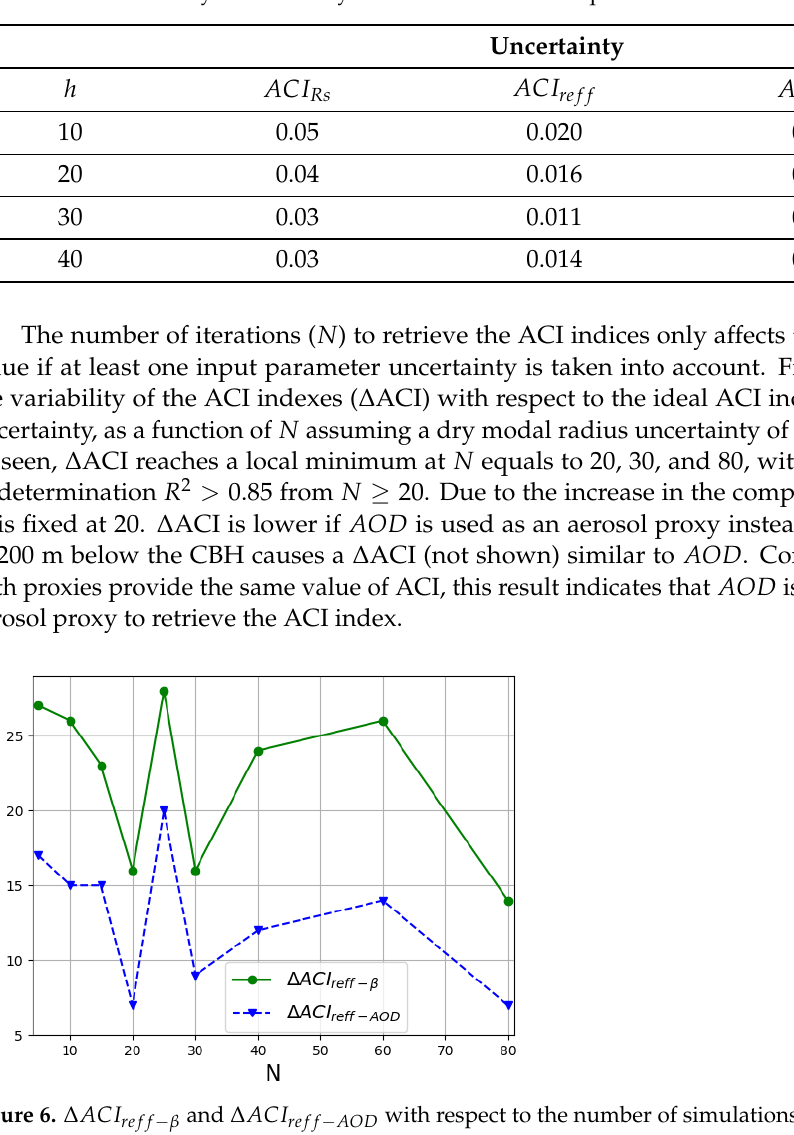
Table 3. ACI uncertainty calculated by the Monte Carlo technique.